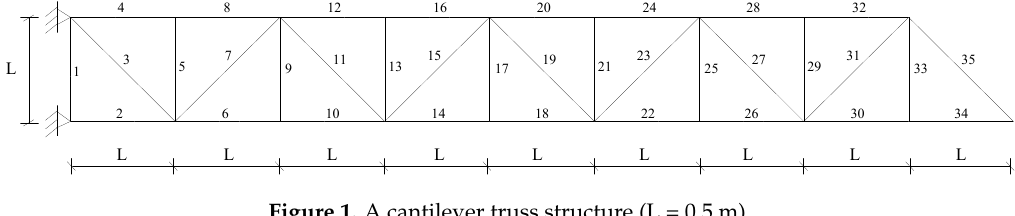
Figure 1. A cantilever truss structure (L = 0.5